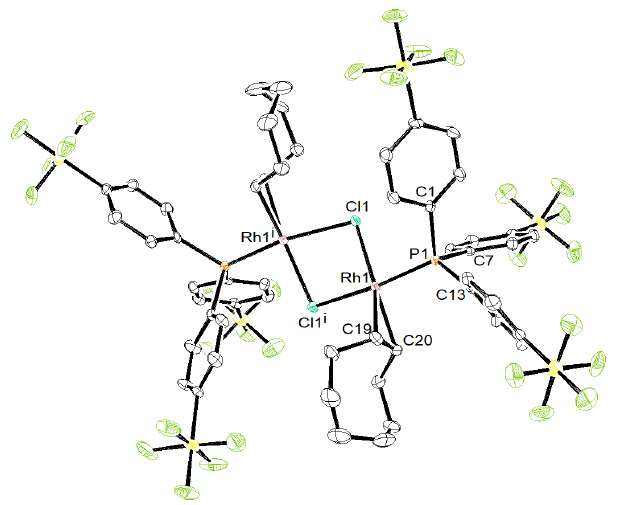
Figure 4. ORTEP representation of 6 with thermal ellipsoids drawn at 50% probability level. Hydrogen atoms and the C 6 H 6 molecule in the unit cell have been omitted for clarity. Selected bond lengths [Å] and bond angles [deg]: Rh1–P1 2.1930(11), Rh1–Cl1 2.3911(11), Rh1–Cl1 i 2.4368(11), Rh1–